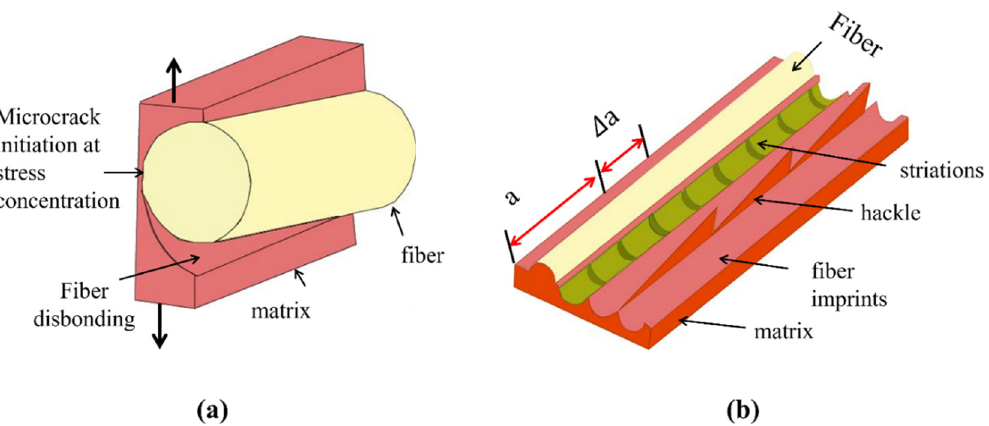
Figure 14. Schematic diagram of ( a ) microcrack initiation in matrix and fibre disbanding ( b ) hackles and striations per unit length [31].